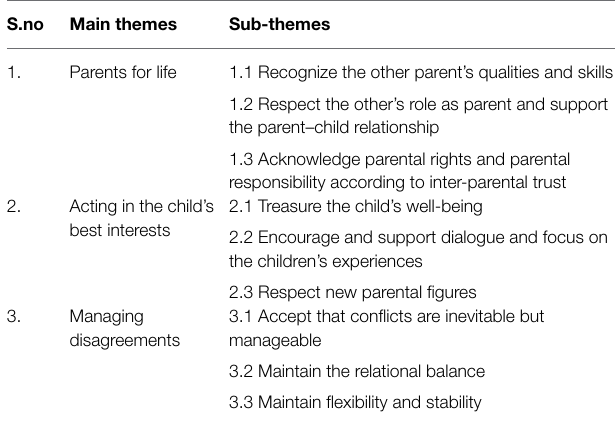
TABLE 1 | Results of Stolnicu and Hendrick (2017) and Stolnicu